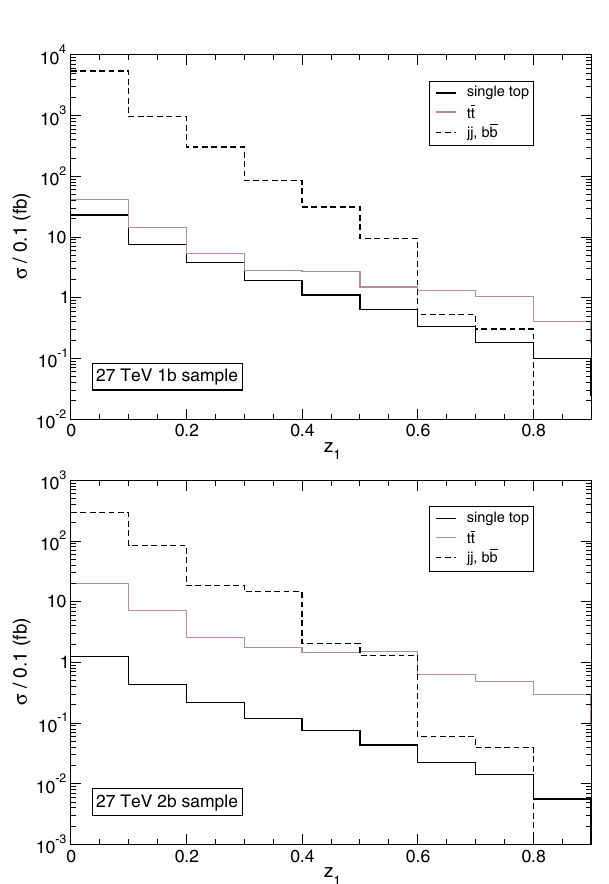
Fig. 6 Signalandbackground crosssectionsasafunctionofthelepton momentum fraction z 1 after the final selection in the 1 b (top) and 2 b (bottom) samples, for a CM energy of 27